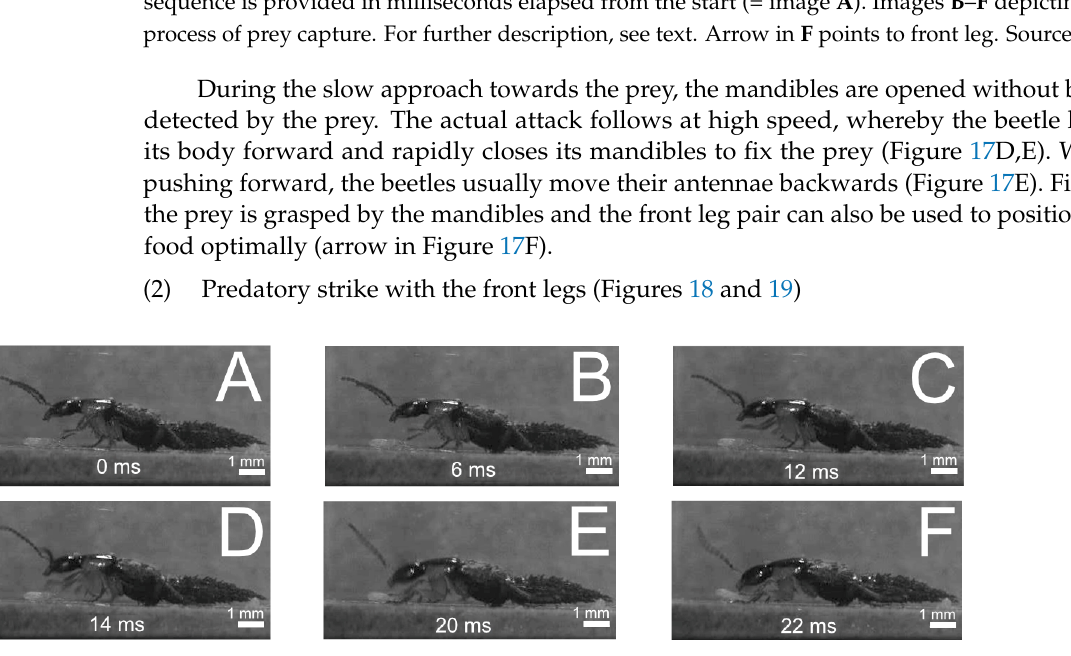
Figure 18. Philonthus marginatus . Predatory strike with the front legs (lateral aspect). Time course of depicted sequence is provided in milliseconds elapsed from the start (= image A ). Images B – F depicting the process of prey capture. For further description, see text. Source: [47].